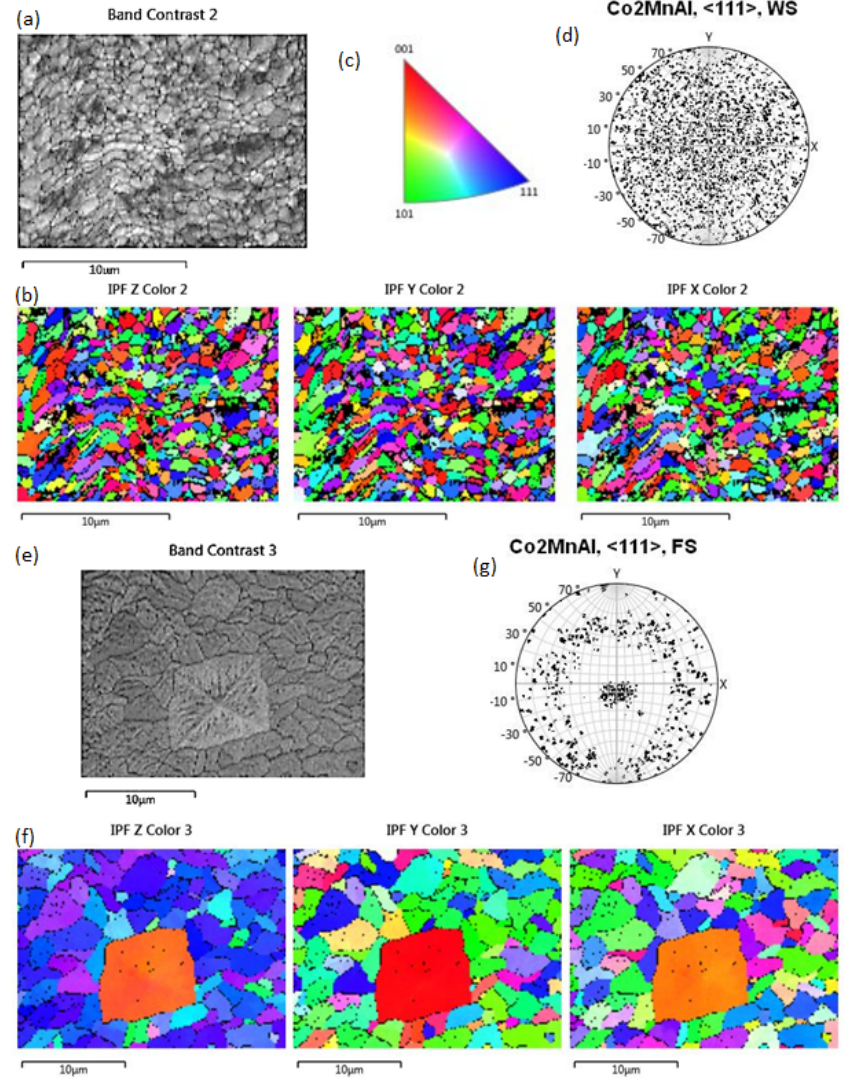
Figure 2. EBSD analysis of the as-spun ribbon surface. At the wheel surface (WS), the crystal orientation of the grains ( a ) is random ( b , c ) in all basic directions: perpendicular to the wheel surface -z; transverzal to the wheel rotation -y; parallel to the wheel rotation -x. This is seen also on the pole figure ( d ) constructed from the EBSD signal. Most of the grains at the ribbon free surface (FS) ( e ) have a <111> crystal axis nearly perpendicular to the ribbon surface ( f ). The declination of the <111> axis by about 10 degrees in the y-direction can be seen on the pole figure ( g ). The big square-shaped grain ( f ) nucleated later at the free surface of the ribbon has a different surface morphology and orientation from the rest of the grains.